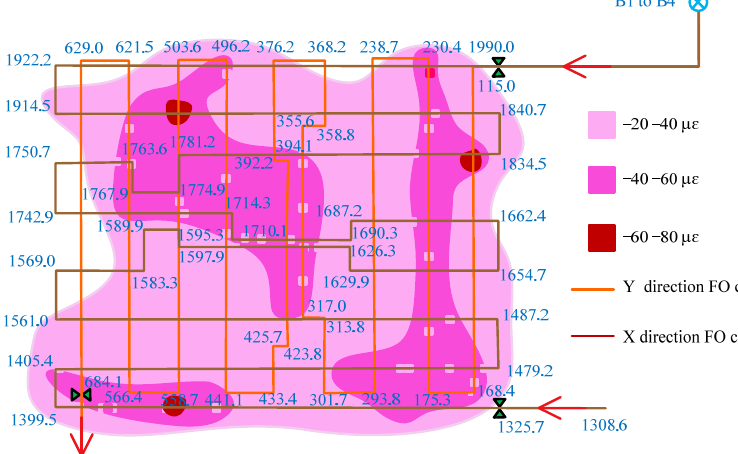
Figure 12. Zones subjected to compression strains.